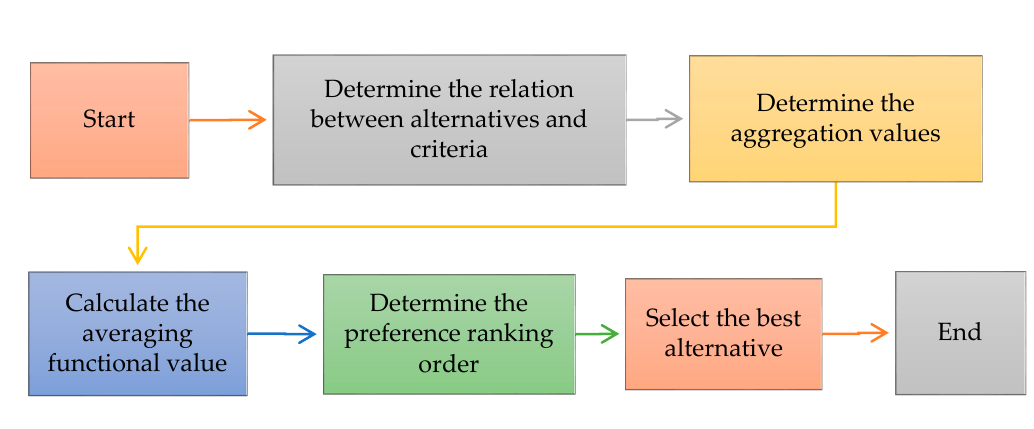
Figure 1. Steps of MCGDM Strategy 1 based on NNHMO.